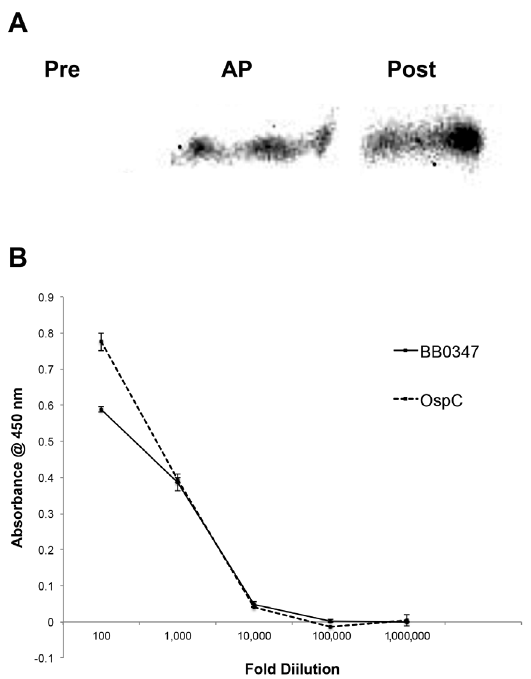
Figure 6. BB0347 is immunogenic in mice. A) Mice were inoculated with B. burgdorferi MI-16 and bleeds were collected before and 8 weeks after the injection of bacteria. Sera from four mice in each category were pooled for Western blotting against purified rBB0347. Lane 1) mouse pre-immune serum, Lane 2) affinity-purified a BB0347, Lane 3) mouse 8-week post infection serum. Bands of the appropriate size were observed in the positive control and infected mouse serum- treated lanes, but not the pre-immune serum treated lane. B) Antibody titers from the pooled sera were determined by ELISA. Values graphed are post-infected serum blanked for pre-infected. Antibodies responded to rBB0347 and OspC in the post-infected sera more strongly than those in the pre-infected sera up to a dilution of 1 6 10 2 4 . Error bars indicate 6 SEM, and data presented are indicative of three independent experiments with equivalent